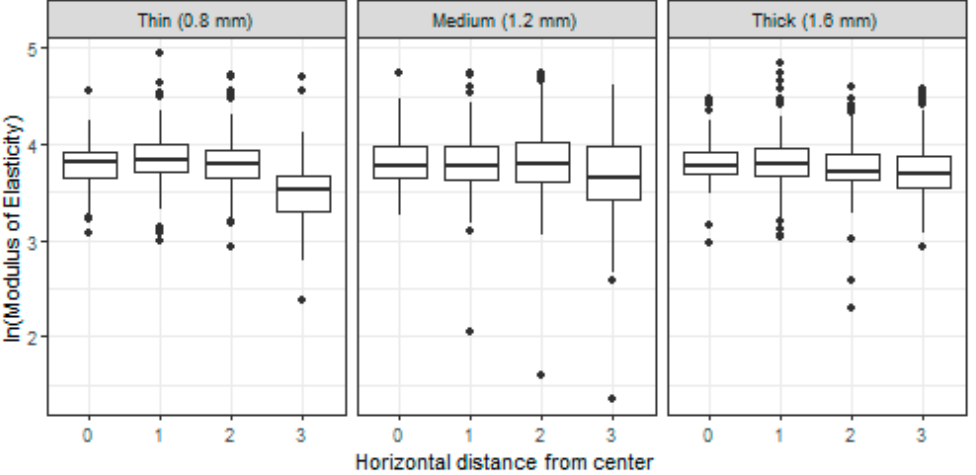
Figure 3. Boxplots of (log-)modulus of elasticity measured on specimens with different root canal and 1.6 mm) and in different distance from the center of a specimen (0–center, wall thickness (0.8, 1.2, and 1.6 mm) and in different distance from the center of a specimen (0– center, 3–periphery).